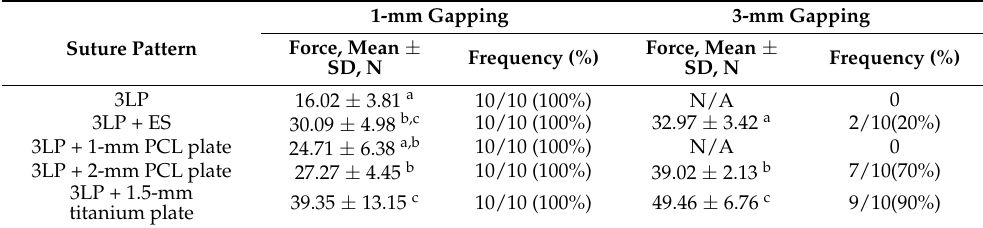
Table 2. Force and occurrence of 1-mm and 3-mm gapping for experimental groups.